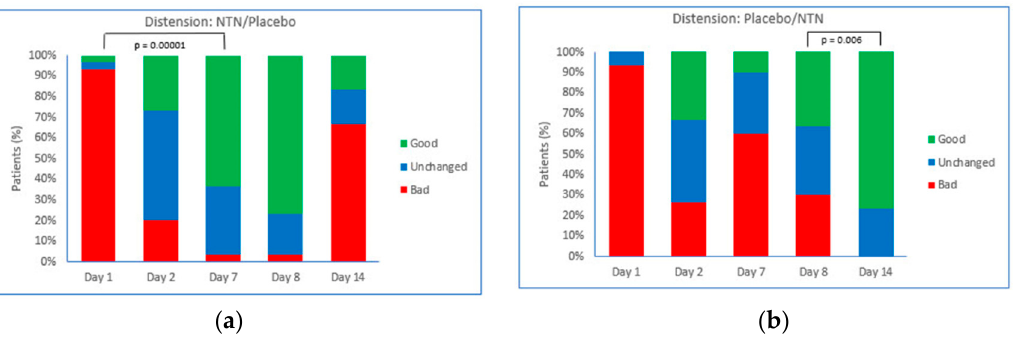
Figure 3. Evolution of distension. Proportion of patients with good, unchanged, or bad Likert scores in groups randomized to receive: ( a ) NTN on Days 1–7 with crossover to placebo on Days 8–14; p = 0.00001, significant decrease in bad distension feeling at Day 7; ( b ) placebo on Days 1–7 with crossover to NTN on Days 8–14; p = 0.006, significant decrease in bad distension feeling at Day 14. Good: somewhat good/good/very good; Unchanged: same; Bad: somewhat bad/bad/very bad; NTN: novel therapeutic of natural origin.